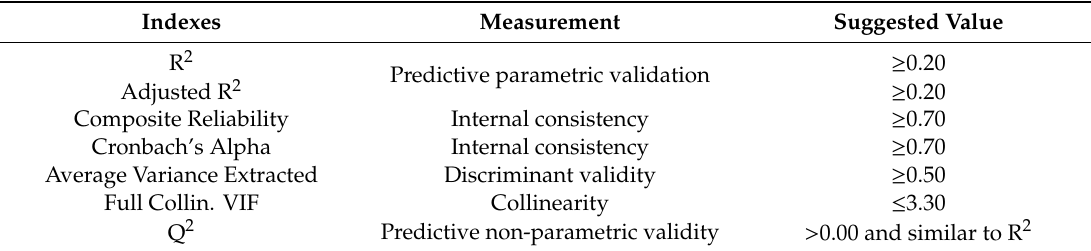
Table 2. Questionnaire validation